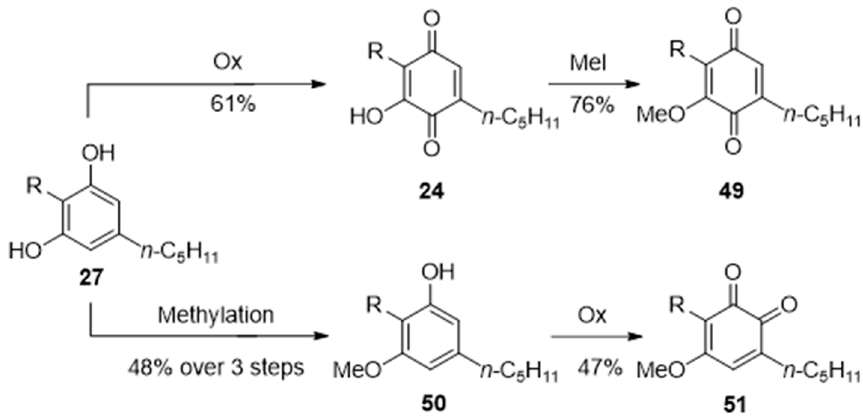
O OH Figure 6. Structure of cannabigerol quinoid dimer ( 48 ). 3.2.2. O -Methylation The ortho, para -prototropic equilibration of enolic cannabinoquinones can be frozen by O -methylation, a maneuver that, depending on the sequence of oxidation and methyl- ation, can afford regioisomeric methylated cannabinoquinones from the same starting phytocannabinoid (Scheme 6). Thus, SIBX oxidation of resorcinolic phytocannabinoids af- fords their p -quinone derivatives, next converted by methylation into their corresponding non-equilibrating O -methyl derivatives [21]. Conversely, if methylation is carried